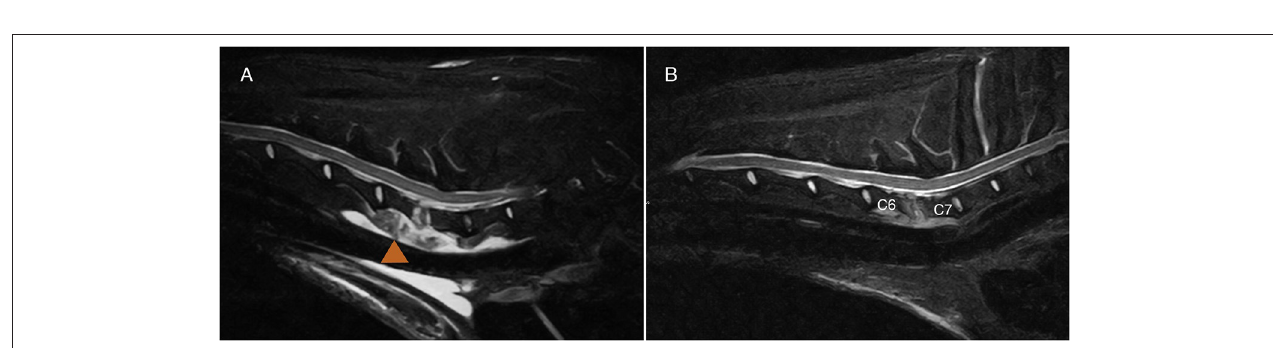
FIGURE 3 | MRI-1 (A) 2 months post-surgery, and MRI-2 (B) 10 months post-surgery of a dog that underwent L1-L2 left hemilaminectomy and T12-L3 IVD fenestrations. The dog developed marked spinal pain and on MRI-1 (A) there was no evidence of neural tissue compression at the previous IVD extrusion site (L1-L2), and evidence of T12-T13 discospondylitis (large arrowhead) corresponding to a previously fenestrated disc site. Note the lack of STIR abnormalities in the other fenestrated discs (small arrowhead).